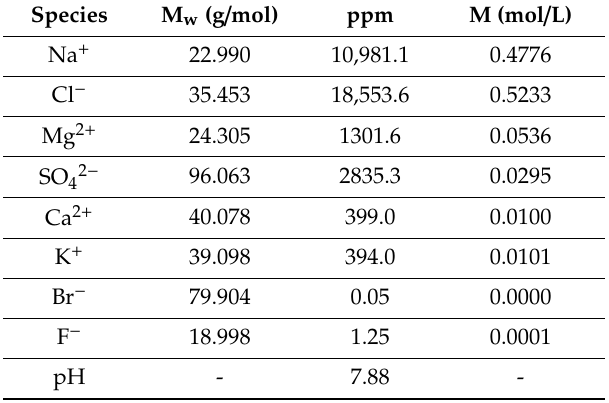
Table 5. Major ion composition and pH of the sea water